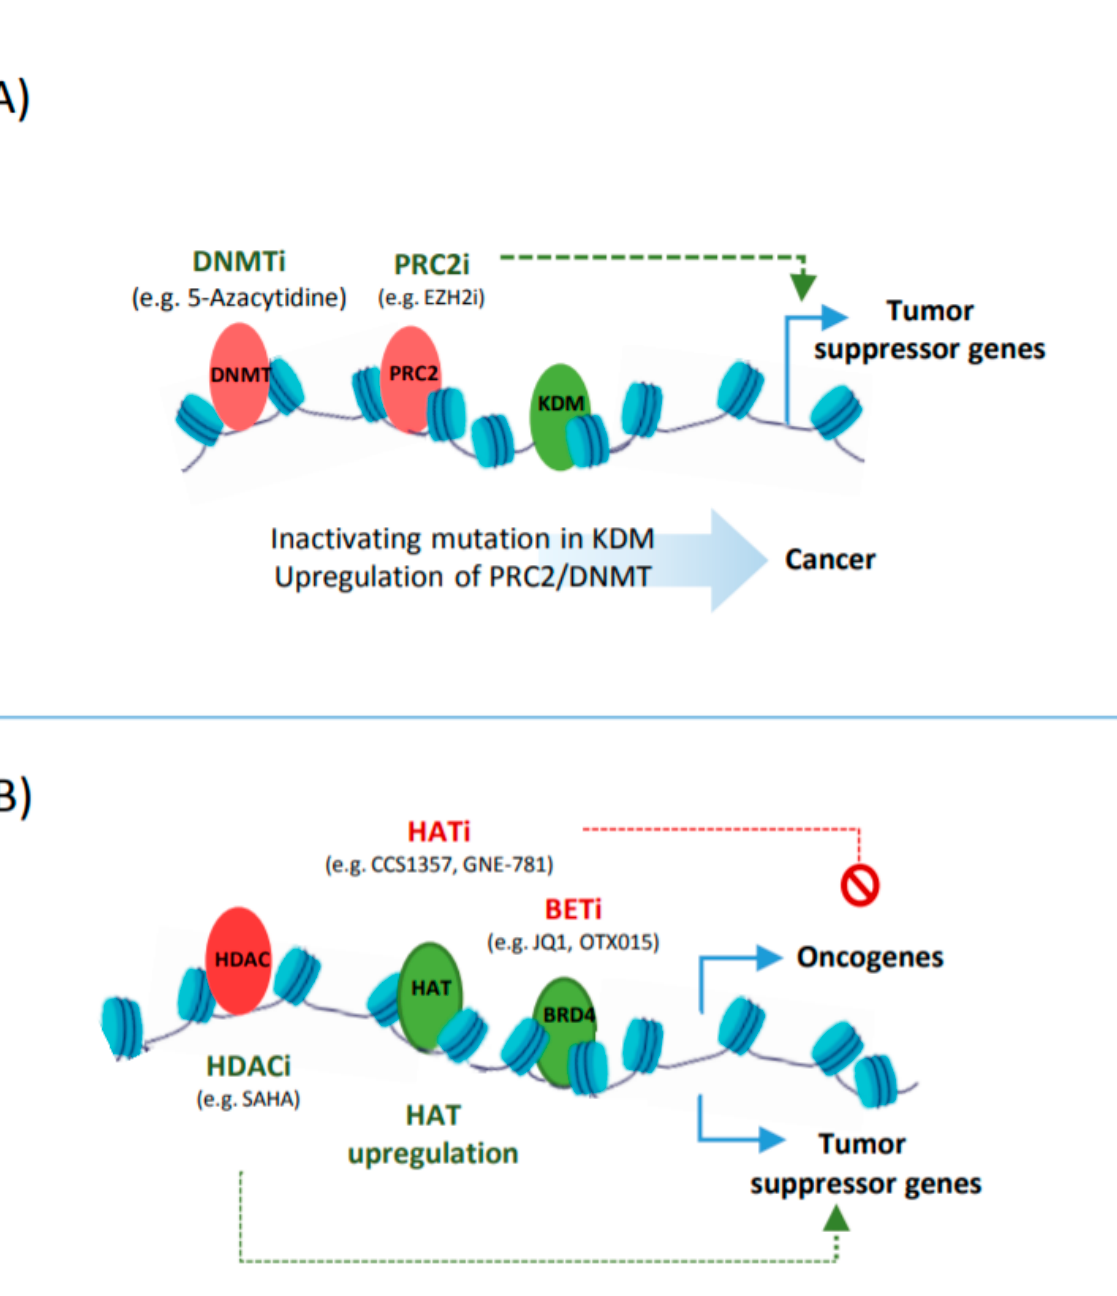
Figure 3. Targeting epigenetic modifiers in cancer by epi-drugs. ( A ) Excessive expression of transcription co-activators such as HATs and BRD4 in tumours leads to upregulation of oncogenes. Inhibition of HATs by CCS1357, GNE-781, JQ1 and OTX015 can abolish their enhancing effect on oncogenes. Hyper activation of HDACs can lead to repression of tumour suppressor genes by removing activating acetyl marks at corresponding regulatory elements. HDAC inhibitors such as SAHA can restore the reduced expression of tumour suppressor genes in cancer. ( B ) Elevated levels of DNMTs and PRC2 can lead to expansion of suppressive methylation marks at regulatory elements that control tumour suppressor genes. Targeting DNMT and PRC activity by chemicals such as 5-Azacytidine and EZH2i, EPZ-6438, can resolve the repressed chromatin and restore the expression of tumour suppressor genes.